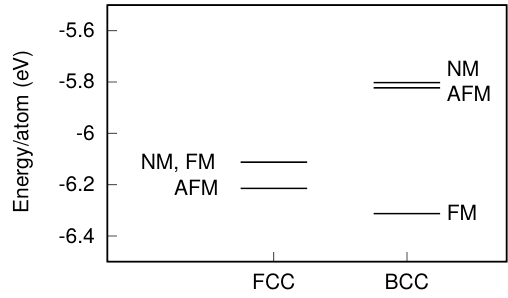
Figure 4. Comparison of the binding energies per atom of iron in the face-centred cubic (FCC) and body-centred cubic (BCC) structures, for ferromagnetic (FM), antiferromagnetic (AFM) and non-magnetic (NM) arrangements of the atomic spins. This illustrates the importance of both crystal structure and magnetic ordering on the overall stability of a magnetic system. Values from